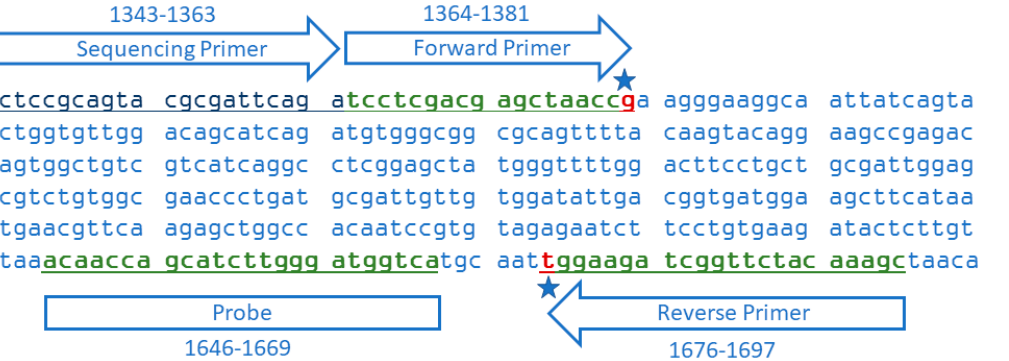
Figure 3. Sequence of part of exon 2 of the SU canola AHAS1C gene showing alignments of the primers and probe for the 334 bp amplicon. The forward primer and probe correspond to the target sequence while the reverse primer is complementary to the target sequence. The star by the forward primer indicates the G that is characteristic of the AHAS 1C gene, distinguishing it from the AHAS 3A gene which has a C at that site. The star on the reverse primer indicates the single SNV that confers herbicide tolerance on AHAS 1C SU and AHAS 3A SU and CL. The sequencing primer is the oligonucleotide use as primer for the Sanger sequencing presented in Figure 2. Table 1. Sequences of primers and probes used. +A denotes the locked nucleic acid (LNA) version of